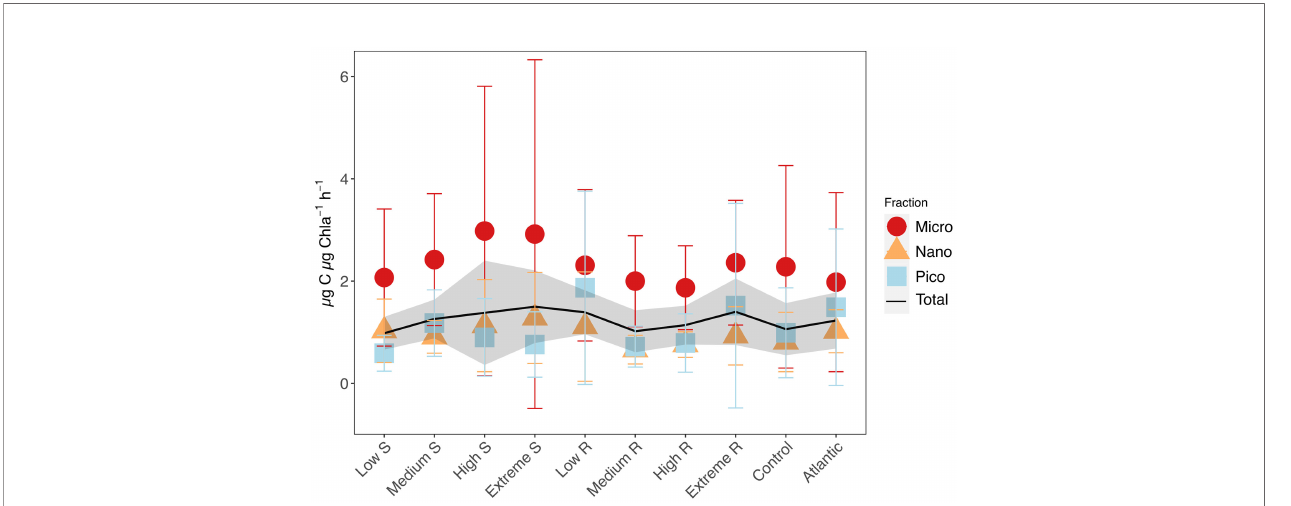
FIGURE 6 | Mean carbon assimilation numbers (AN) and standard deviations for total phytoplankton, microphytoplankton (20-250 µm), nanophytoplankton (2-20 µm) and picophytoplankton (0.2-2 µm). Shaded area shows standard deviation for total phytoplankton